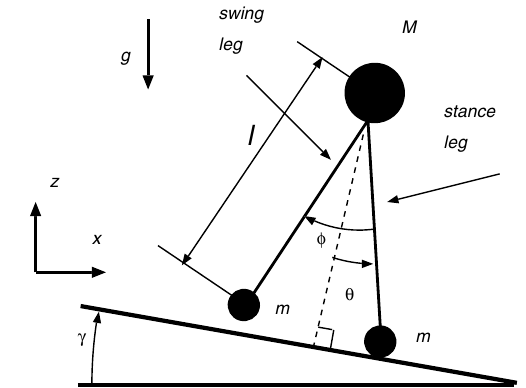
Figure 1 Simplest walking model (Schwab et al . 2001). It is a 2D model with no knees. θ indicates the angle of the stance leg to the direction of the gravitational vector and ϕ the angle between both